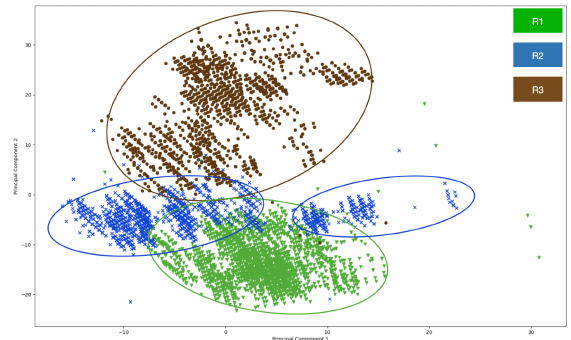
Figure 4. Scatter plot showing RSSI measurements after missing data imputation procedure divided into three classes corresponding to three rooms (R1, R2 and R3).